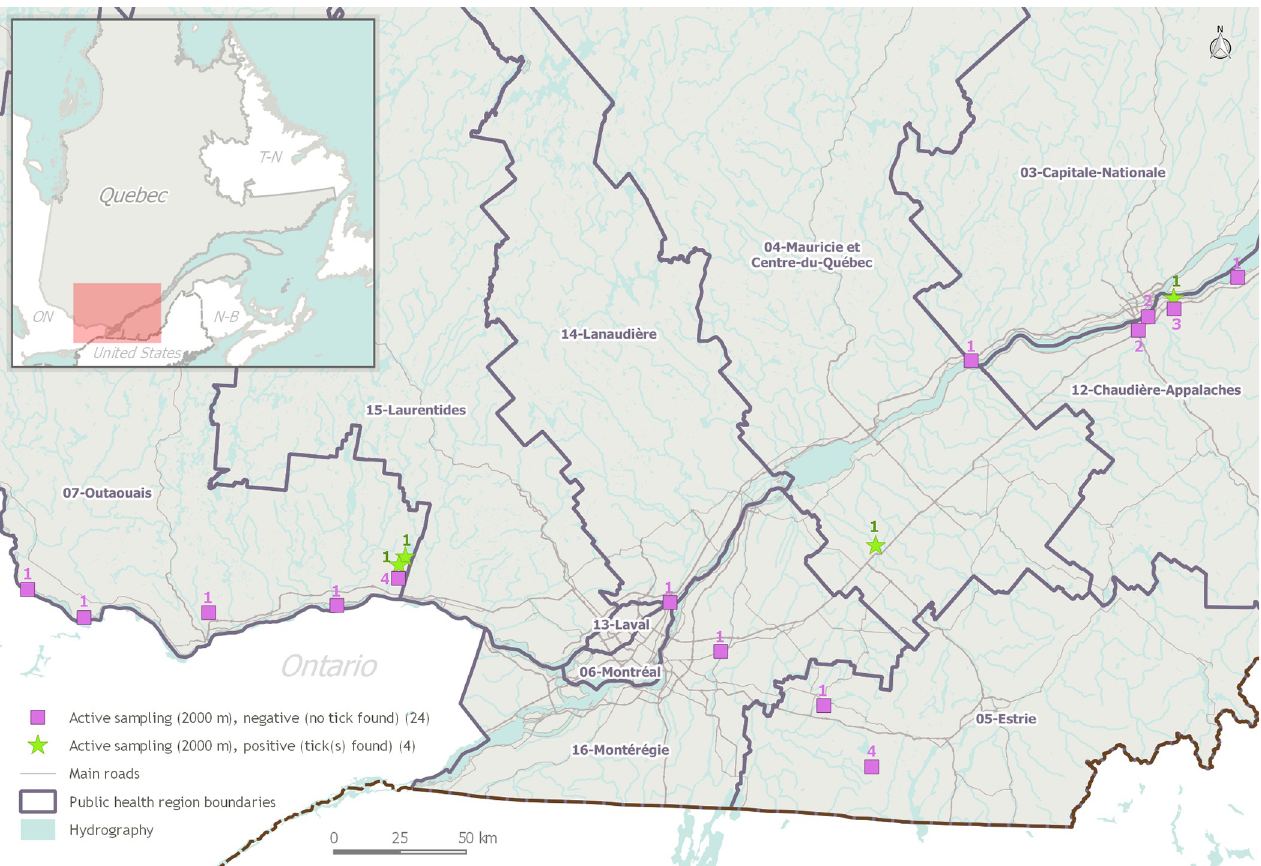
Fig 4. Spatial distribution and quantities of ambassador-led tick sampling activities across the province. A total of 28 tick samplings were organised by ambassadors between May and September 2019 (18 different locations, in seven PHUs). Of these, four samplings allowed tick detection (green, n = 4). The remaining samplings (purple, n = 24) were completed (2000 m sampled) but led to no detection. Note: This map was created using open-access geographic layers produced by the Gouvernement du Québec